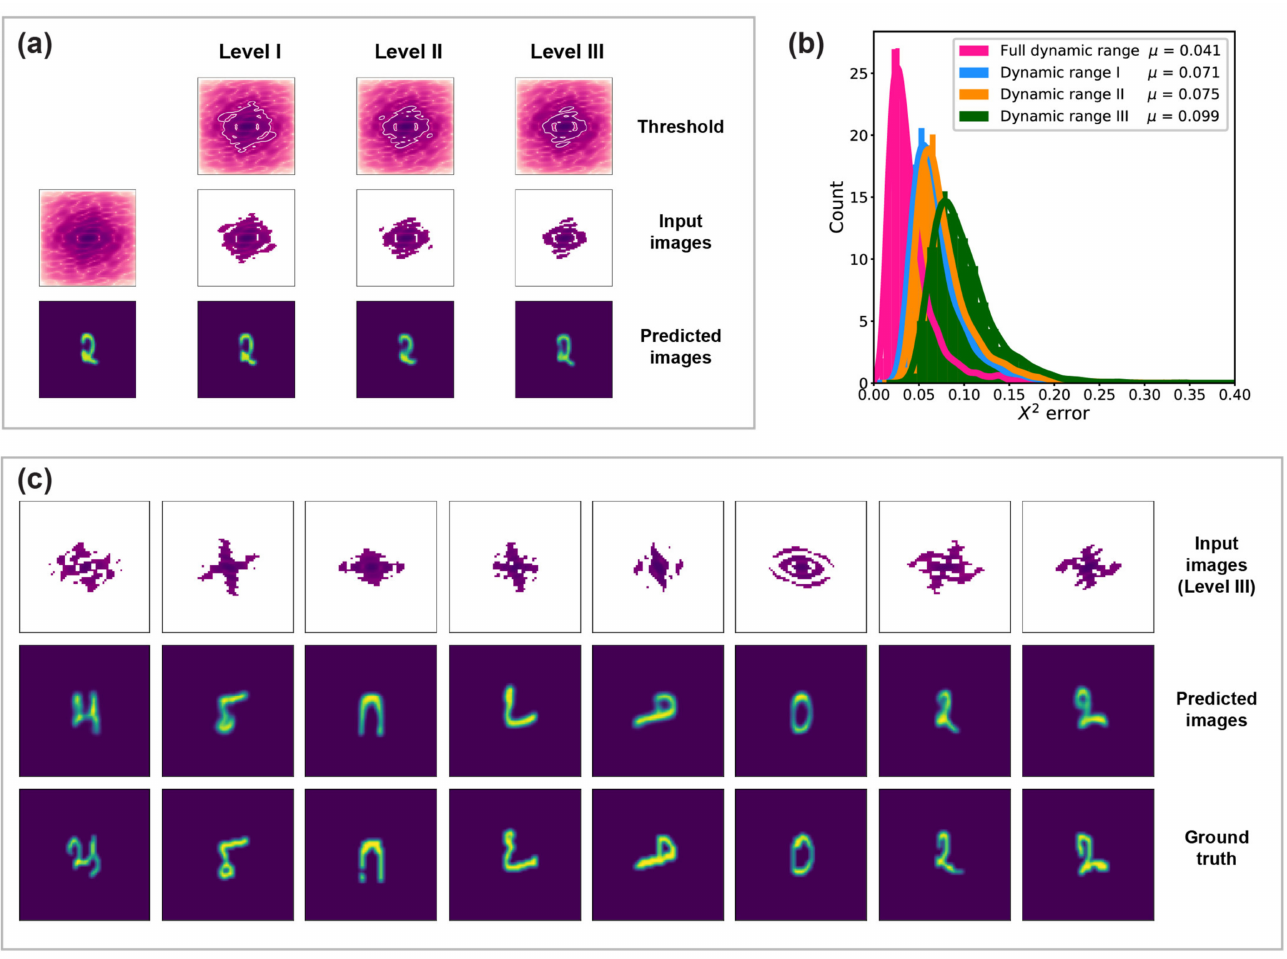
Figure 5. ( a ) Input images and corresponding predicted images. The thresholds defined as white contours in the first row, result in the different dynamic ranges of input images in the second row. The third row shows the predicted images based on the corresponding input images. ( b ) The comparison of performance. The average ( µ ) of X 2 error increases as the detection dynamic range decreases. ( c ) The first row shows a series of input images that have the level III detection dynamic ranges. The second and third row show the predicted images and ground truth,